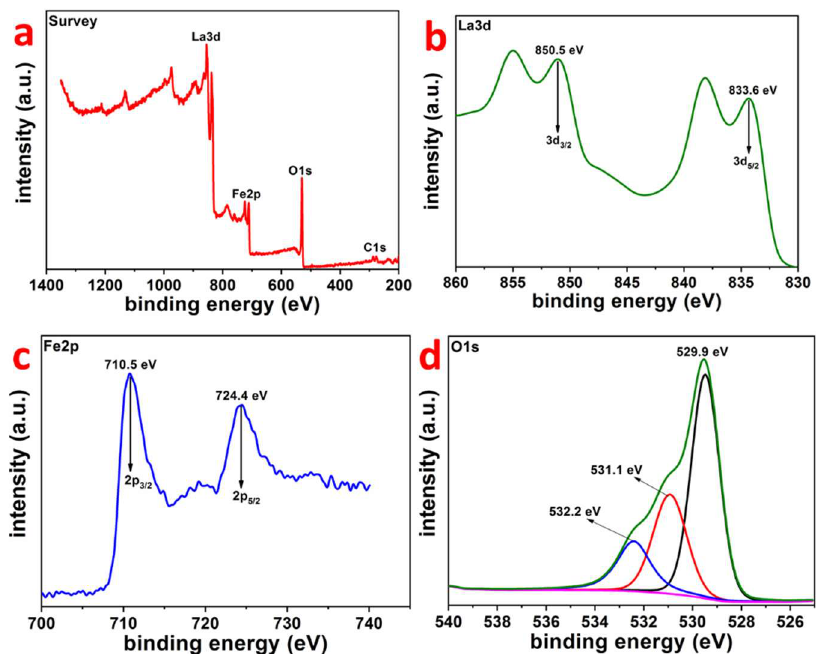
Figure 7. X-ray photoelectron spectroscopy (XPS) for the S-700 sample survey ( a ), and core level XPS of La 3d ( b ), Fe 2p ( c ) and O1s ( d ).